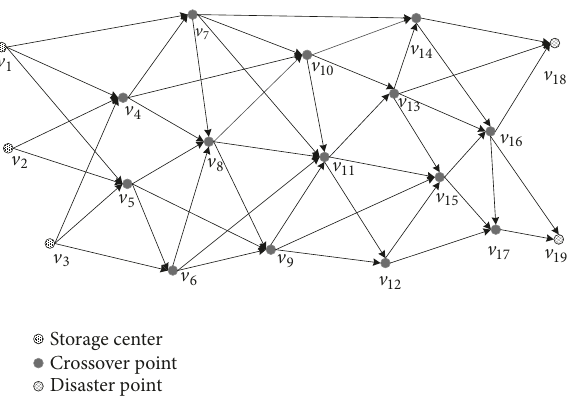
Figure 8: The ETN in case